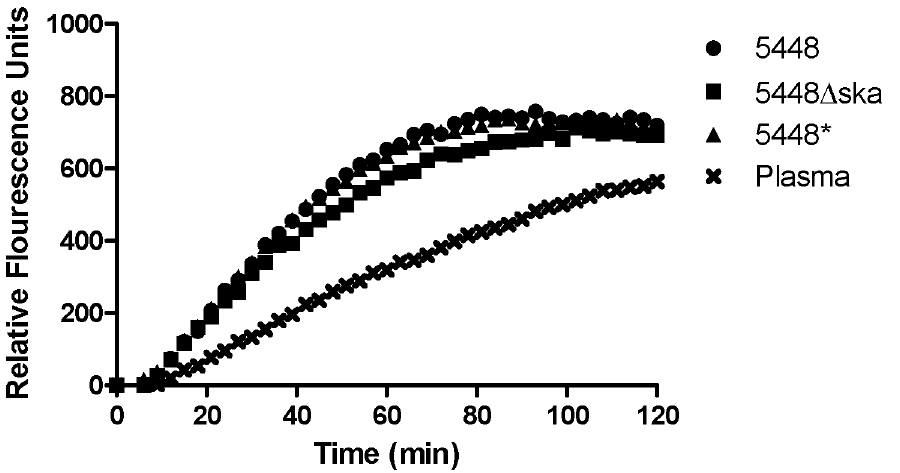
Figure 2. GAS facilitates enhanced uPA activity in plasma. Endogenous uPA activity in human plasma was measured using the uPA specific fluorogenic substrate Z-Gly-Gly-Arg-AMC, in the presence or absence of GAS strains 5448, 5448* and 5448 D ska . Data is representative of four independent experiments, performed in duplicate. Background fluorescence has been subtracted from all values.